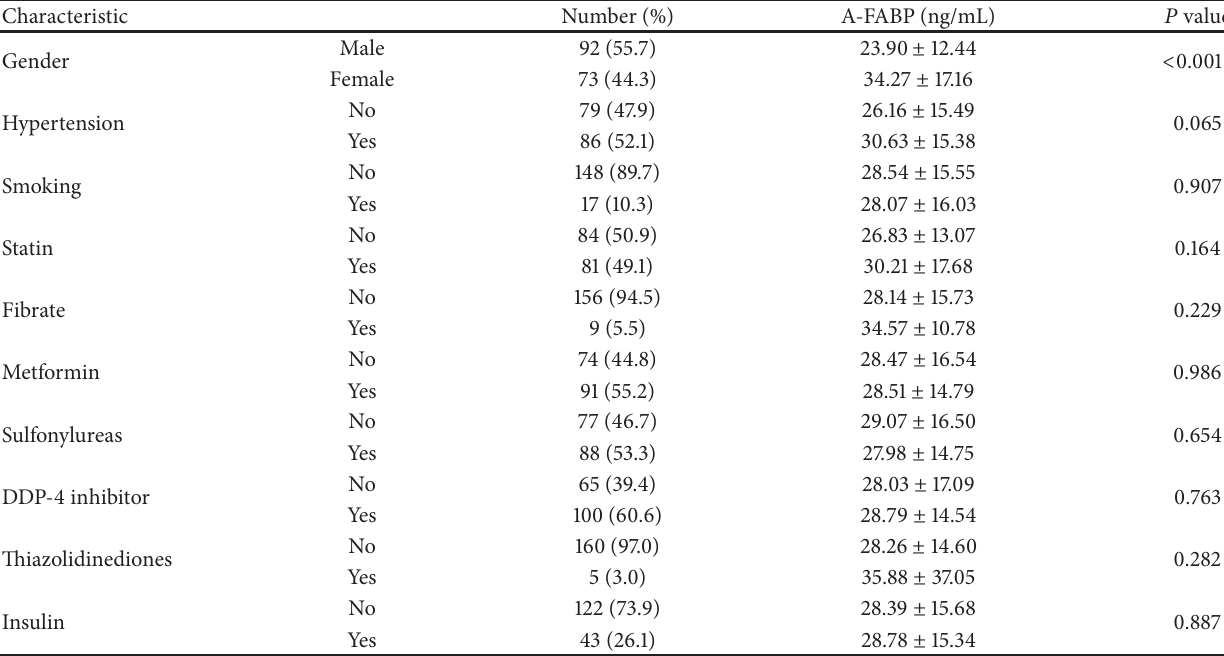
Table 2: Clinical characteristics and fasting serum adipocyte fatty acid binding protein levels of 165 diabetic patients.